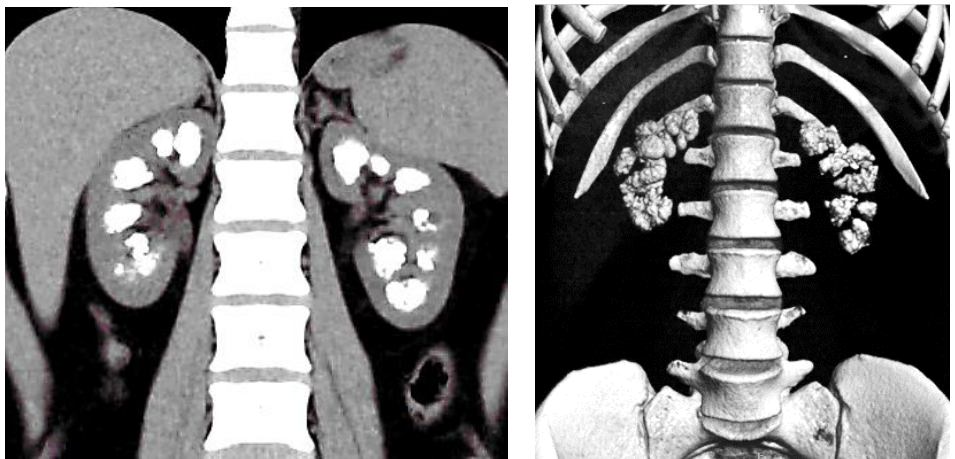
Figure A1. Coronal reformation of unenhanced CT-scan shows bilateral numerous pre-calyceal lithiasis and severe medullary nephrocalcinosis but without uretero-hydronephrosis.